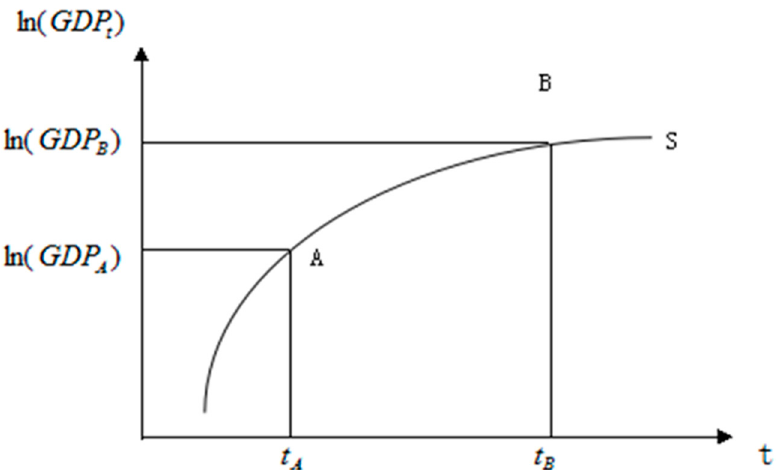
Figure 1. Absolute convergence. Note: A and B denote two random times, respectively. The gross provincial product growth rate on time A ( t A ) is higher than time B ( t B ), though t B is linked to a higher gross provincial product. The growth rate decreases as the gross provincial product increases, and S represents the final steady-state.